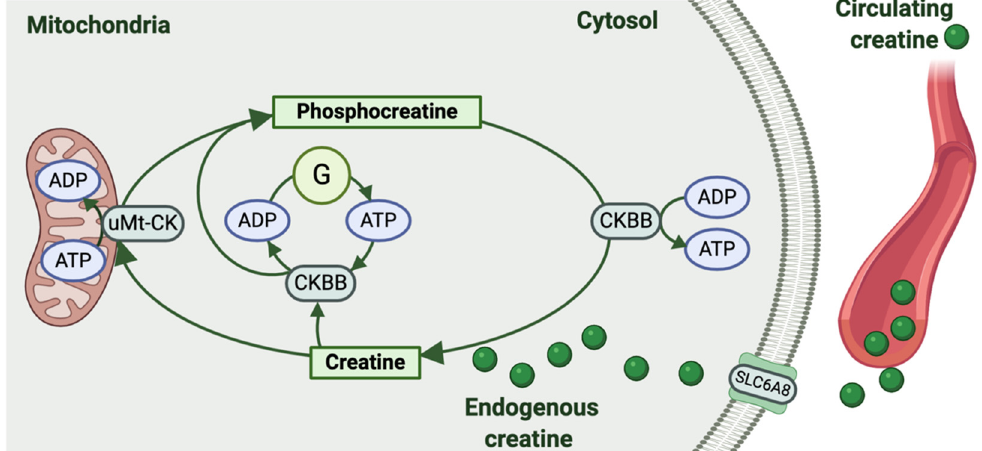
Figure 1. The creatine kinase circuit. Creatine can be produced endogenously by some cells or taken up from the circulation via the creatine transporter (SLC6A8). Creatine is then phosphorylated from adenosine triphosphate (ATP) to form phosphocreatine and adenosine diphosphate (ADP) in a reaction catalyzed by ubiquitous mitochondrial creatine kinase (uMt-CK). Isoforms of creatine kinase in the cell cytosol (mainly brain-type creatine kinase CKBB) are also linked to glycolytic enzymes (G) to generate phosphocreatine and ADP from glycolytic ATP. Then, when required for energy-dependent cellular processes, cytosolic isoforms of creatine kinase (CKBB) hydrolyze the bond between creatine and the phosphate group stored as phosphocreatine, thus regenerating ATP and creatine. Note: muscle-type cytosolic creatine kinase (CKMM) expression has also been detected in mouse oocytes.